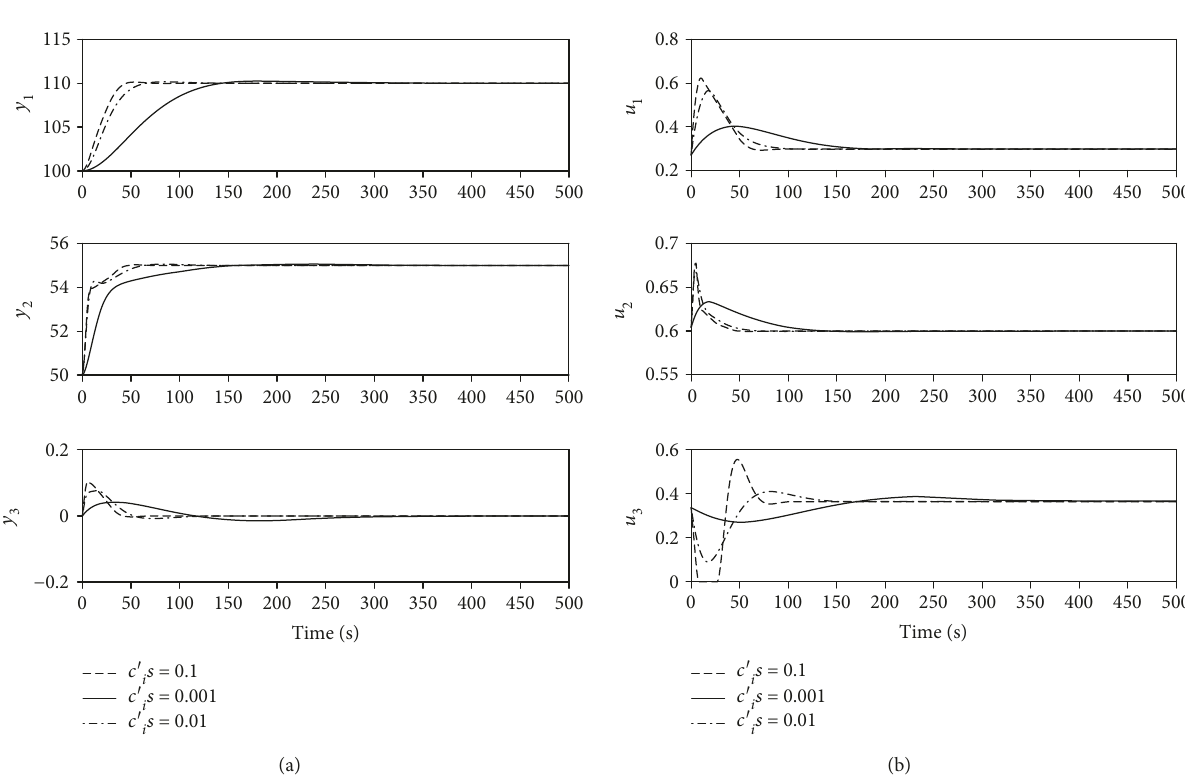
Figure 6: Outputs and controls of the unit when taking di ff erent values of expansion coe ffi cients c